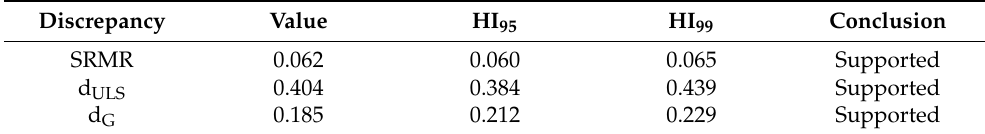
Table 2. Model fit